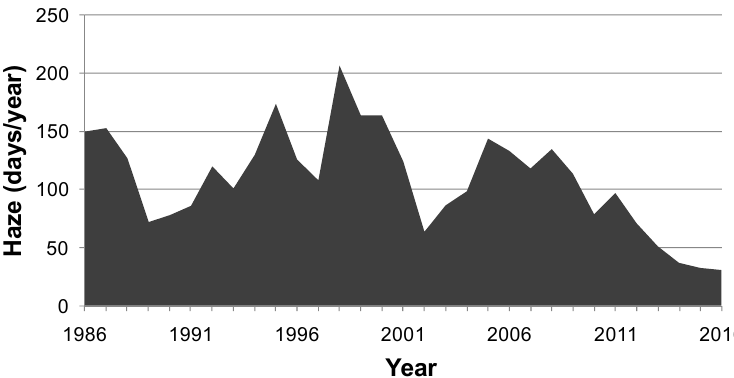
Figure 5. The numbers of haze days in Guangzhou over the period 1986–2016.